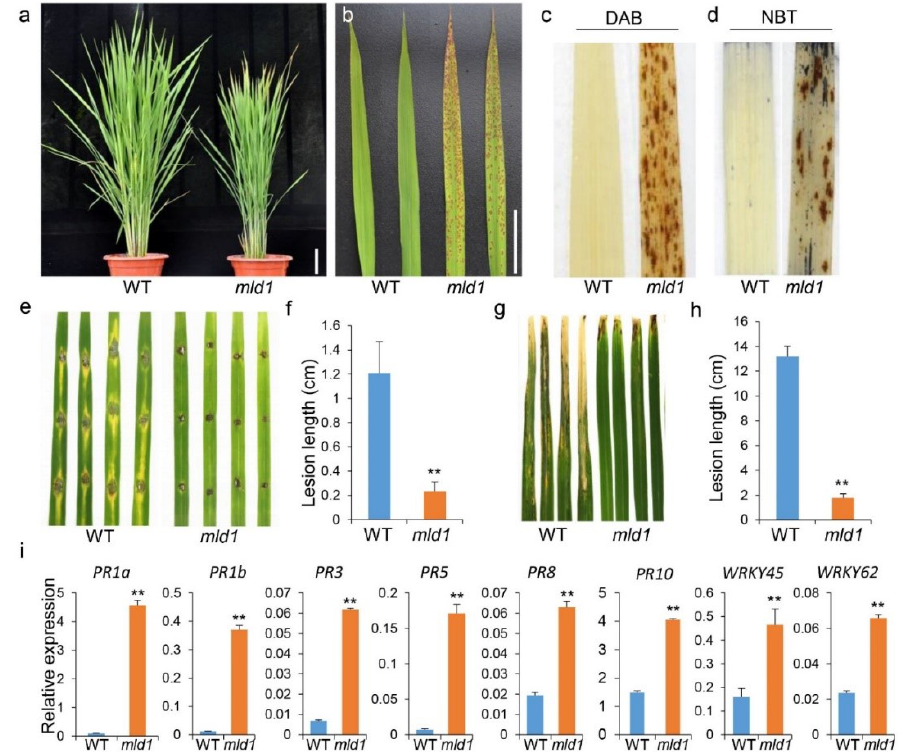
Figure 1. Phenotypic analysis of the mld1 mutant of rice ( Oryza sativa ). ( a , b ) Plants at 90 days after seed sowing in the paddy field. Scale bar: 10 cm. ( c , d ) DAB ( c ) and NBT ( d ) staining of the WT and mld1 mutant leaves to indicate the accumulation of H 2 O 2 and O 2 − , respectively. ( e , f ) Leaves of the wildtype (WT) and mld1 mutant plants inoculated with the compatible M. oryzae isolate H535. Phenotype and lesion length at 120 h after punch inoculation with H535 spores. Data are the means ± SD ( n = 12). ( g , h ) Inoculation of the mld1 mutant and WT plants with the Xoo isolate PXO 99. Phenotype and lesion length at 14 dpi. Data represent the means ± SD ( n = 4). ( i ) Expression analysis of several defense-related genes in the WT and mld1 mutant plants based on RT-qPCR. Total RNA was extracted from the leaves of 30 day old seedlings. Data were normalized to the expression of the OsACTIN1 gene. Values are the means ± SD ( n = 3). Significance analysis of the data ( f , h , i ) was performed using Student’s t- test (** p < 0.01).